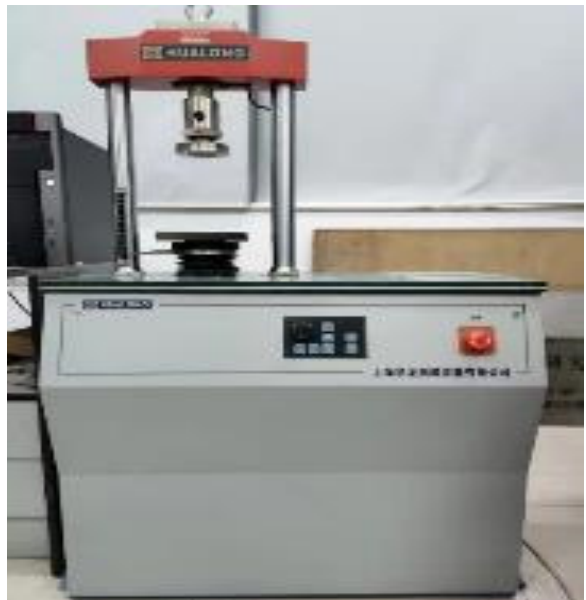
Figure 3. Profile of UCS test.